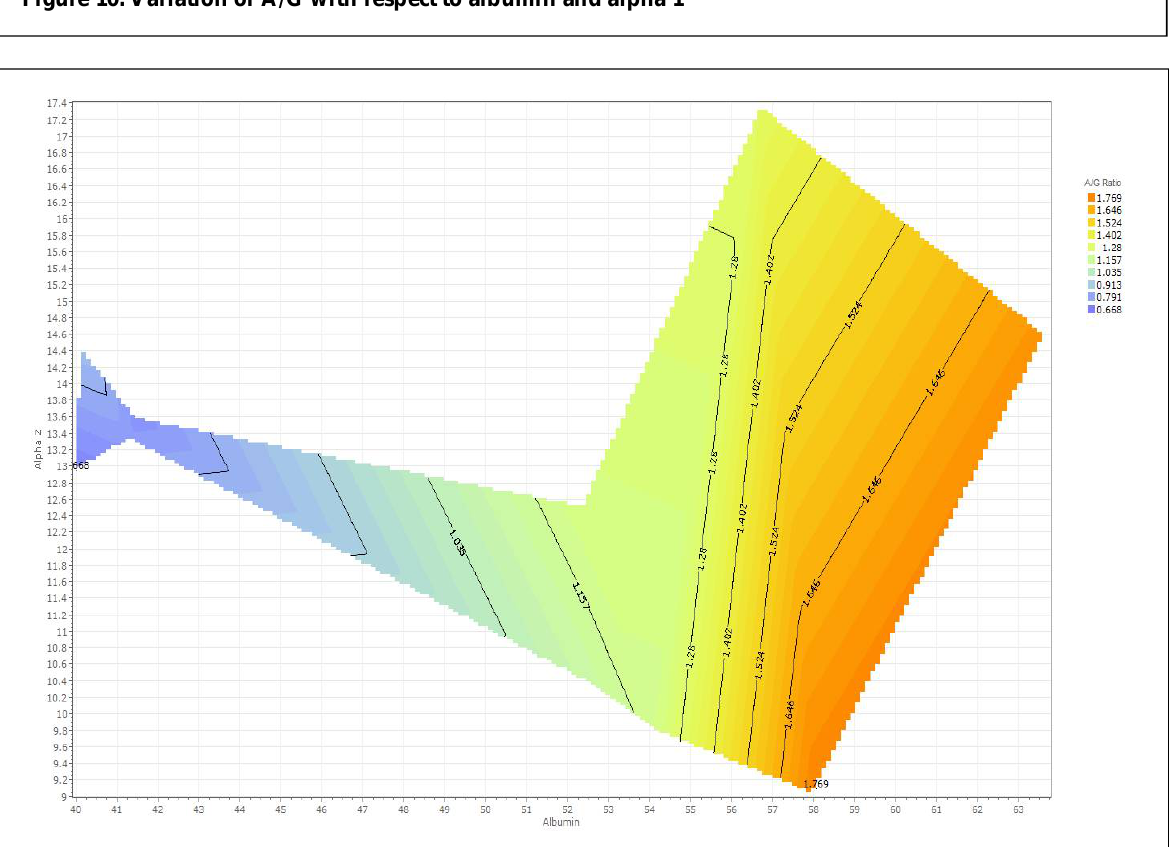
Figure 10: Variation of A/G with respect to albumin and alpha 1